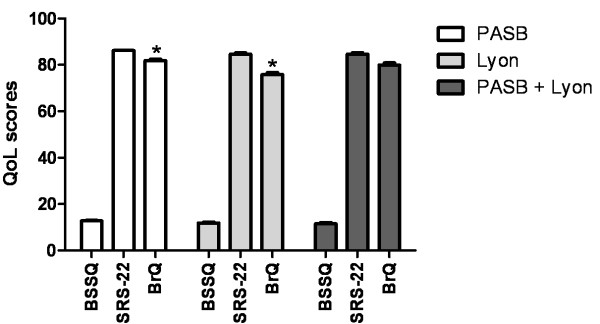
Summary QoL according to the type of bracing (* p < 0.05).